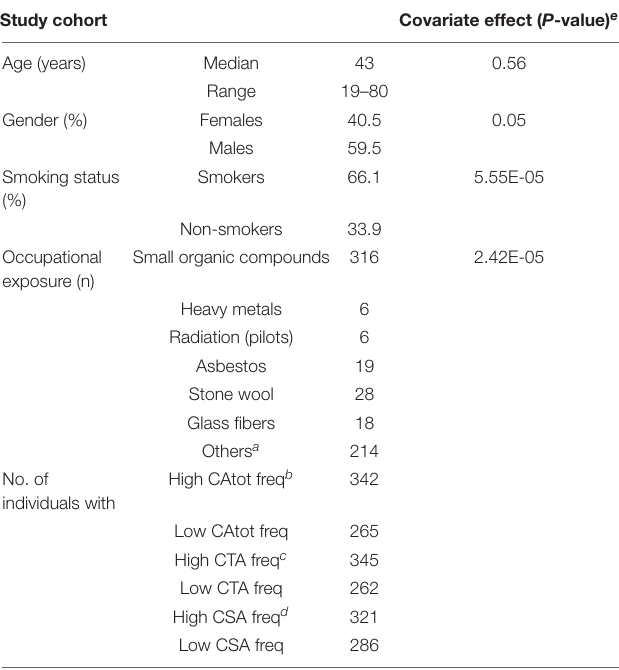
TABLE 1 | Descriptive attributes of the study cohort and exposure-based